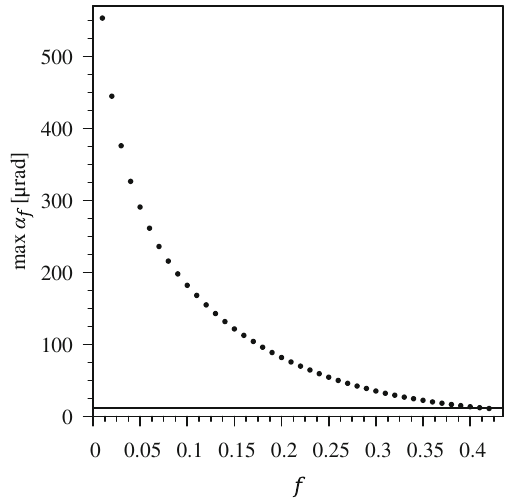
Fig. 7 The dependence of the maximum angle by which the given fraction of particles can be deflected on f for E = 300 GeV. The line shows the value of the critical angle of planar channeling